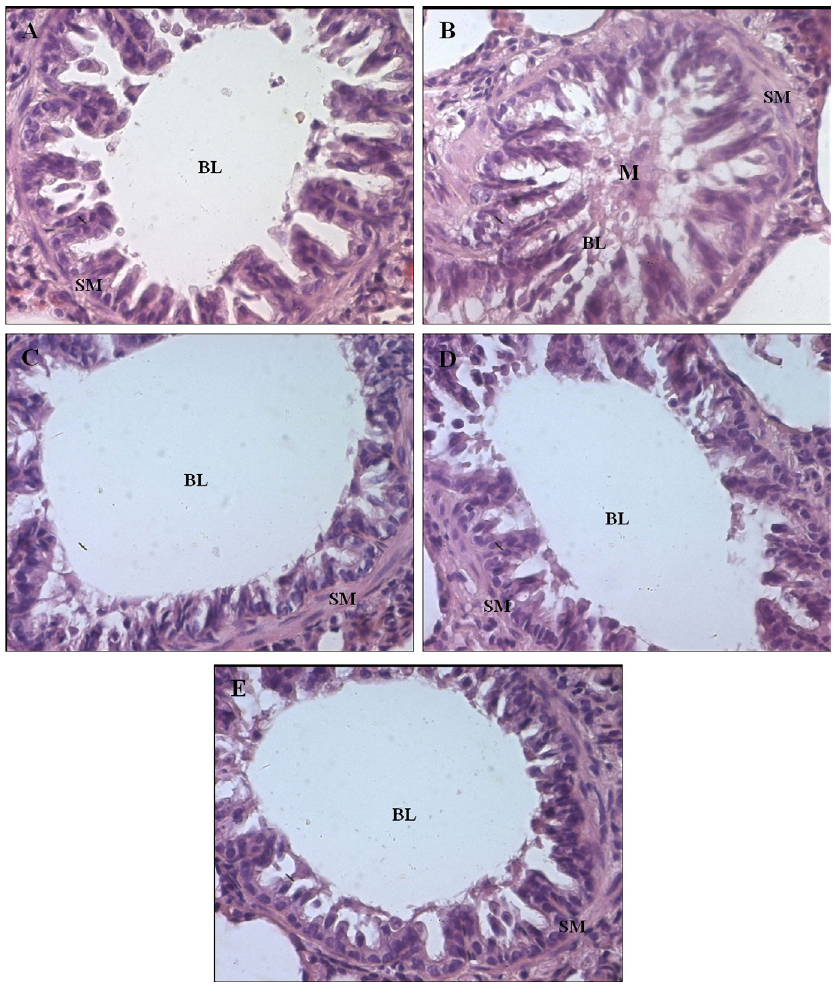
FIGURE 2 - Photomicrographs of hematoxylin-eosin-stained lung sections from rats showing the structure of a representative bronchus. (A) after inhalation of saline. (B) after Mech challenge: note the bronchoconstriction, the increase of the smooth muscle (SM) layer and the abundance of mucus (M) in the bronchial lumen (BL). (C), (D) and (E) after metacholine + terbutaline, metacholine + PACAP and metacholine + PACAP38-analog treatment, respectively: note the bronchodilator effect of Terb, PACAP38 and PACAP38 analog. Magnification: ×400. TABLE I - Airway sizes of medium-sized bronchi examined for morphometry in the different experimental groups Experimental groups